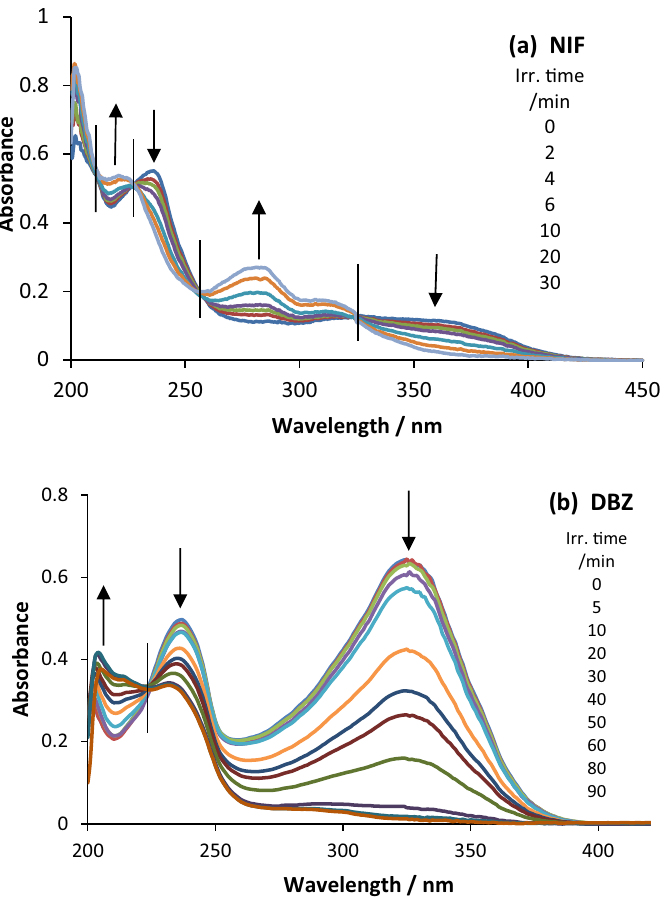
Figure 3. Evolution of the absorption spectra of ( a ) NIF (2.67 × 10 –5 M) and ( b ) DBZ (5.41 × 10 –5 M) in ethanol, when subjected to increasing irradiation time intervals. The polychromatic light (200–400 nm) was delivered by a mixed-wavelength lamp (254/365 nm, Fig. 1). Arrows indicate direction of absorbance change; vertical lines cross the spectra at the isosbestic points.